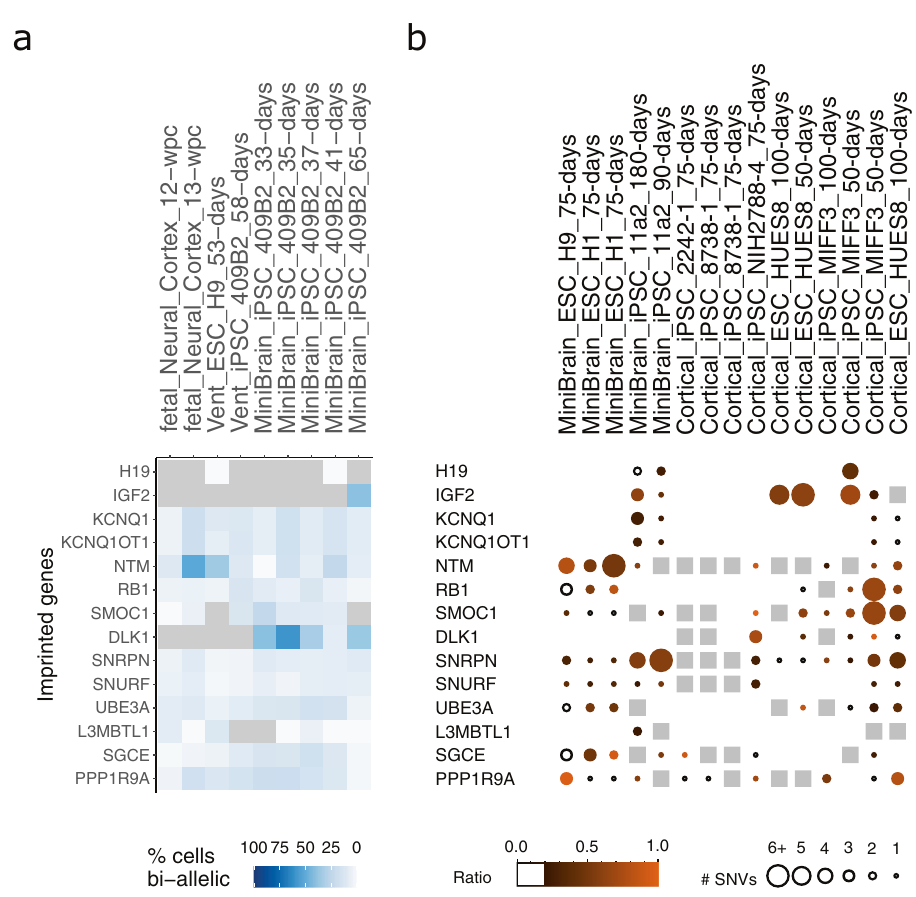
Fig. 3 Analysis of bulk and single-cell RNA-seq data from human organoids for 14 selected genes. a Analysis of single-cell RNA-seq data from the fetal neocortex, cortical-like ventricle from cerebral organoids (Vent) and whole-cerebral organoids (minibrains). Gray indicates undetected genes.